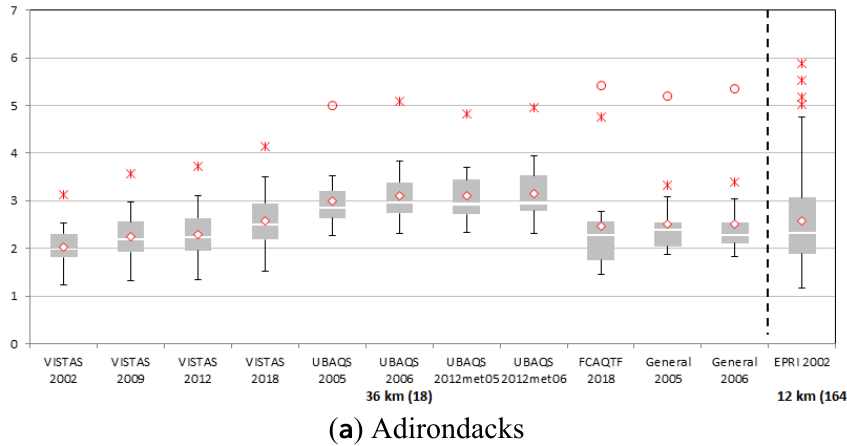
Figure 8. Box and whisker plots for variability in LNH and ( b ) Shenandoah across all the model simulations. The number in parentheses represents the number of each sample data. How to read a box and whisker plot is explained in the Figure 5